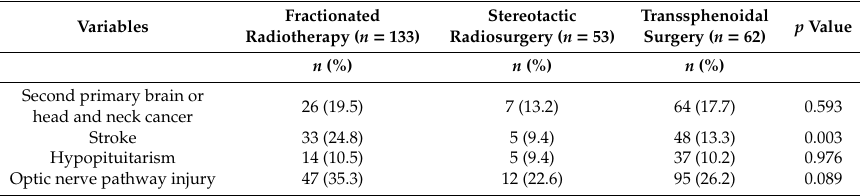
Table 2. Toxicity profiles of patients with nonfunctioning pituitary macroadenomas who received fractionated radiotherapy, stereotactic radiosurgery, or transsphenoidal surgery. Fractionated Stereotactic Transsphenoidal Variables Radiotherapy ( n = 133) Radiosurgery ( n = 53) Surgery ( n =